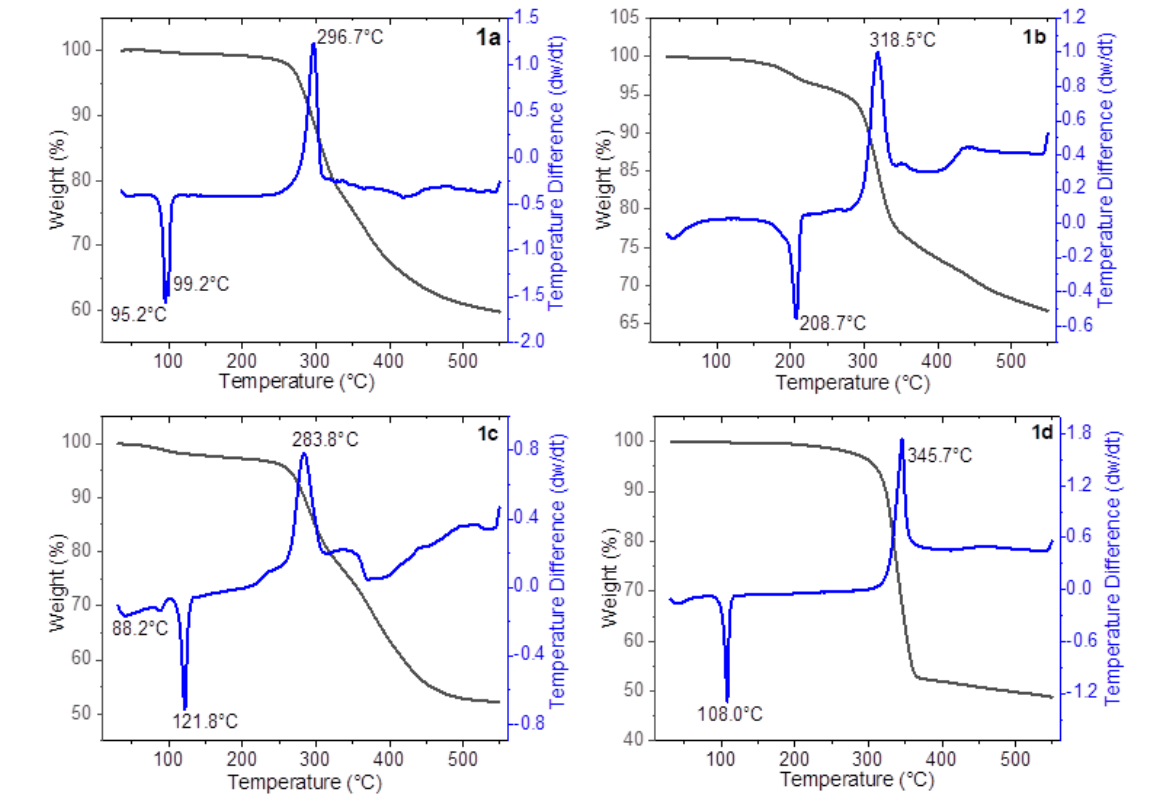
Figure 4. Simultaneous TGA–DSC curves of the thermal decomposition of pentacoordinated organ- otin(IV) complexes 1a – 1d , under flowing dry N 2 (50 mL·min − 1 ) and at a heating rate of 10 °C·min − 1 .